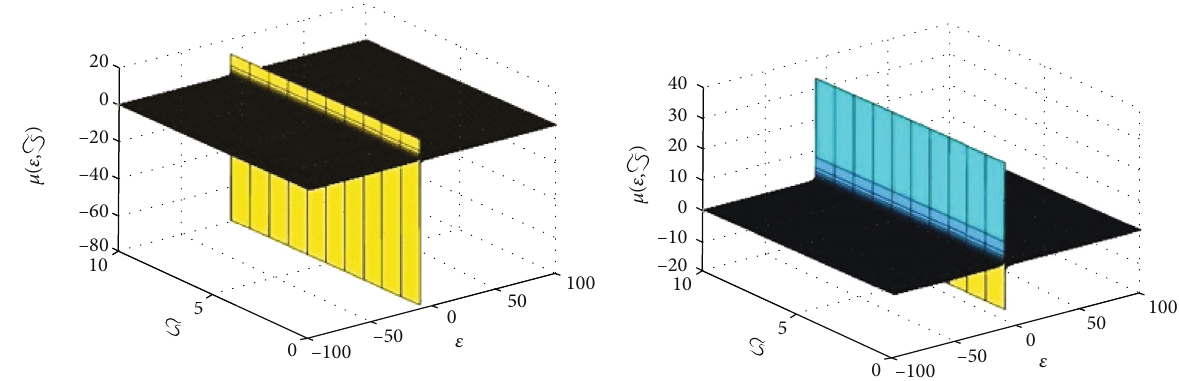
Figure 3: The di ff erent fractional-order of ϑ = 0 : 8 and 0 : 6 of the